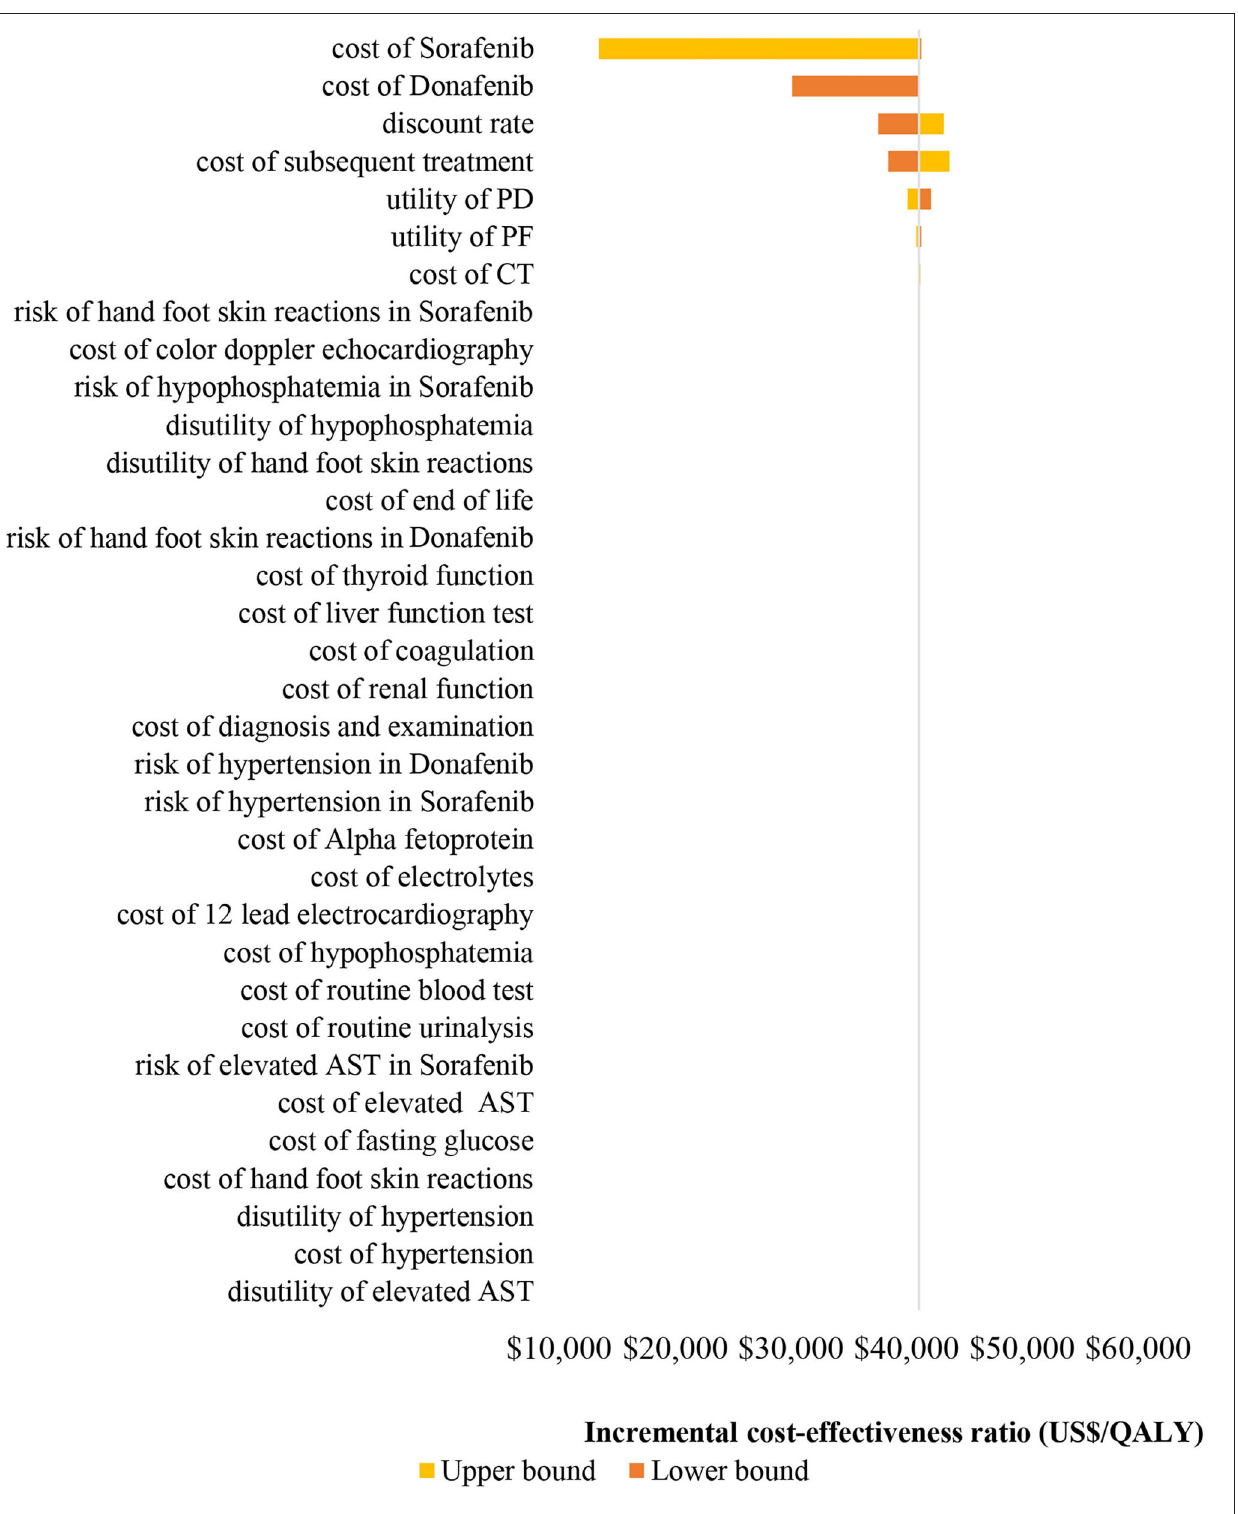
FIGURE 2 | Tornado diagram of the one-way deterministic sensitivity analyses. PF, progression-free; PD, progressed disease; CT, computed tomography; AST, aspartate aminotransferase; QALY, quality-adjusted life-year.